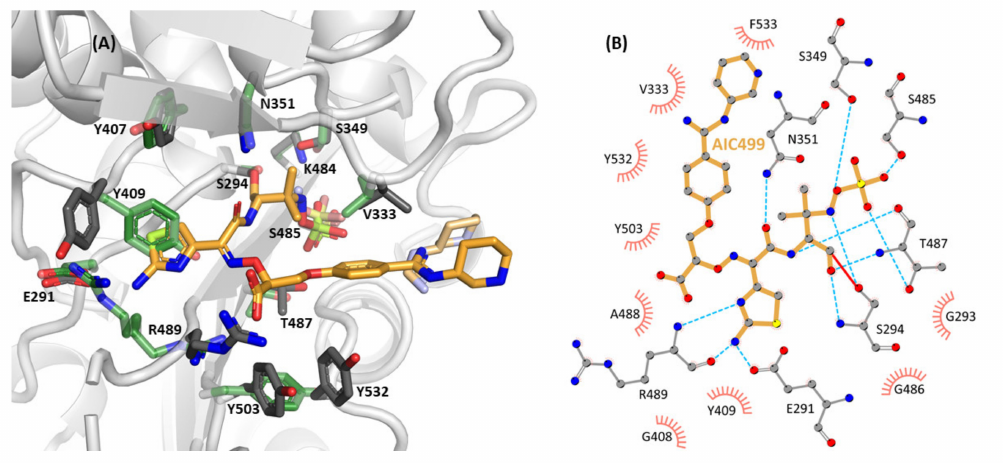
Figure 6. Structure of AIC499 within the active site of Pa PBP3 ∆ TM. ( A ) 3D representation of the covalently bound ligand together with the most relevant interacting side chains (gray) and their counterparts in the apo structure (crystal form 2, green). Alternative conformations of the amidine-based head group and the terminal sulfate moiety are shown in lighter color. ( B ) LigPlot+ representation of individual contacts. Hydrogen bonds (cyan) are plotted for donor-acceptor distances between 2.3 Å and 3.2 Å, while hydrophobic interactions (salmon) have distances between 3.0 Å and 4.0 Å. A complete list of distances between protein side chains and the AIC499 compound is provided in Table